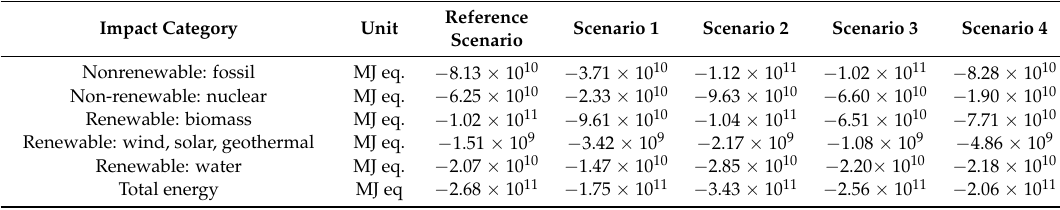
Table A10. Energy use in the different